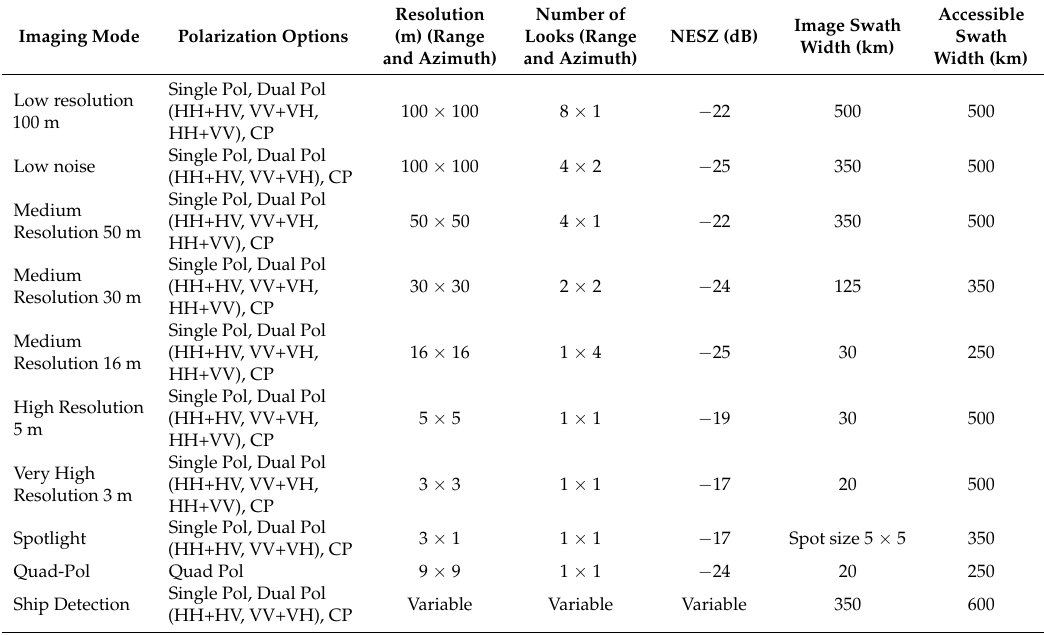
Table 1. A description of the RADARSAT Constellation Mission (RCM) imaging mode parameters